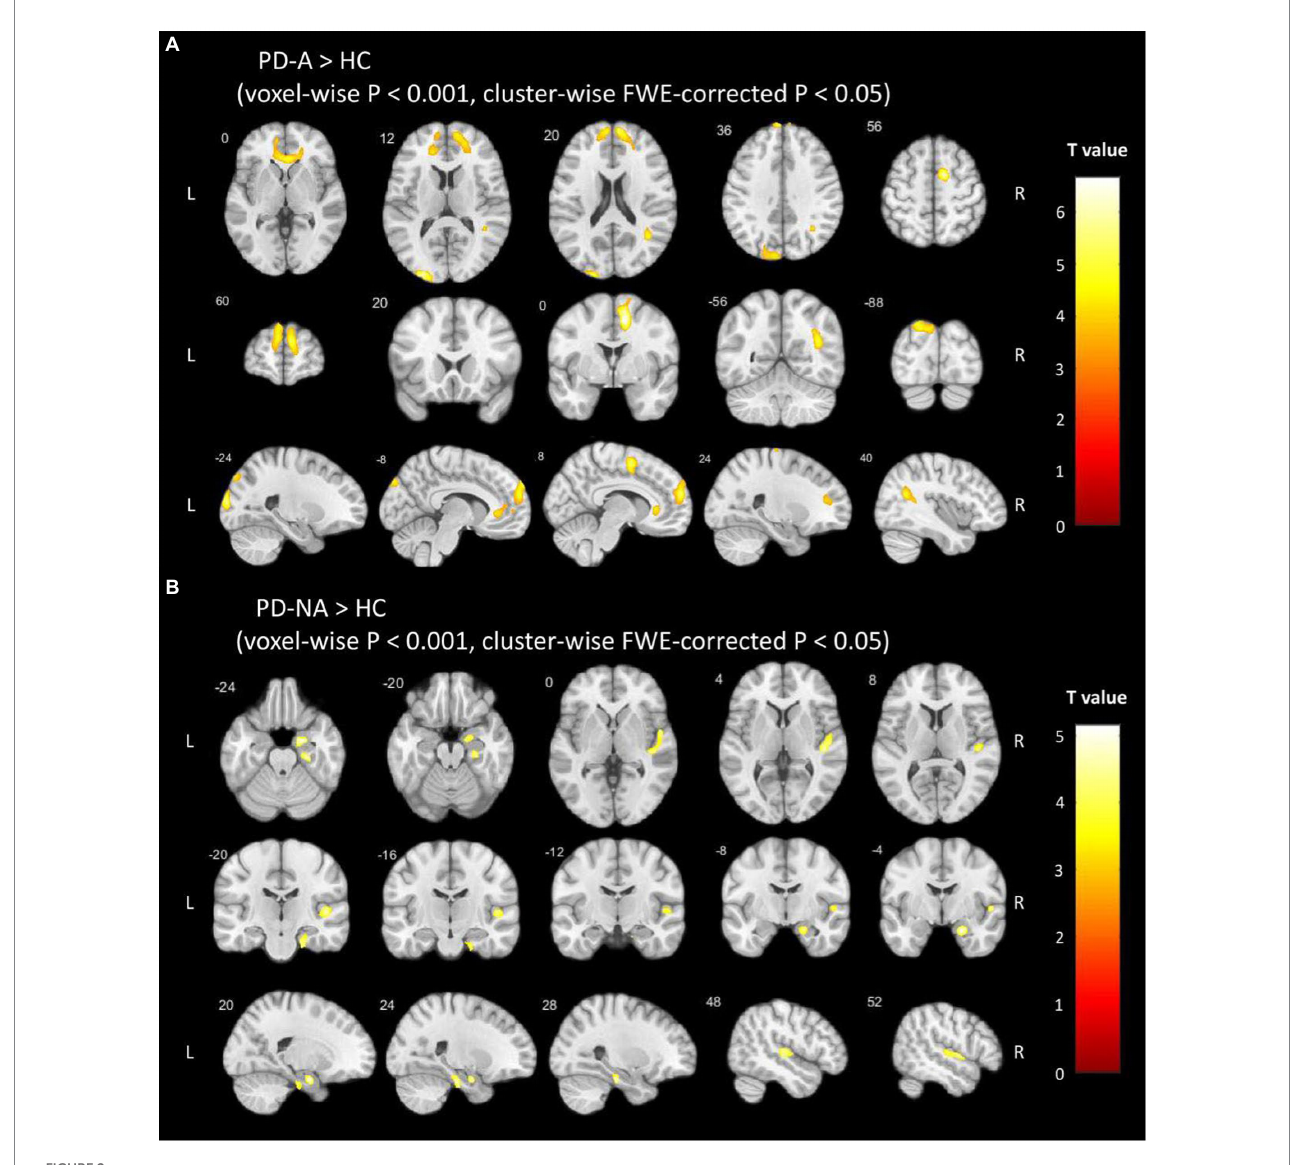
FIGURE 2 Voxel-based QSM analysis. The clusters with warm color represent significantly (A) increased QSM values in the PD-A group than in the HC group and (B) increased QSM values in the PD-NA group than in the HC group. FWE, family-wise error; PD-A, Parkinson’s disease with anxiety; PD-NA, Parkinson’s disease without anxiety; HC, healthy control.